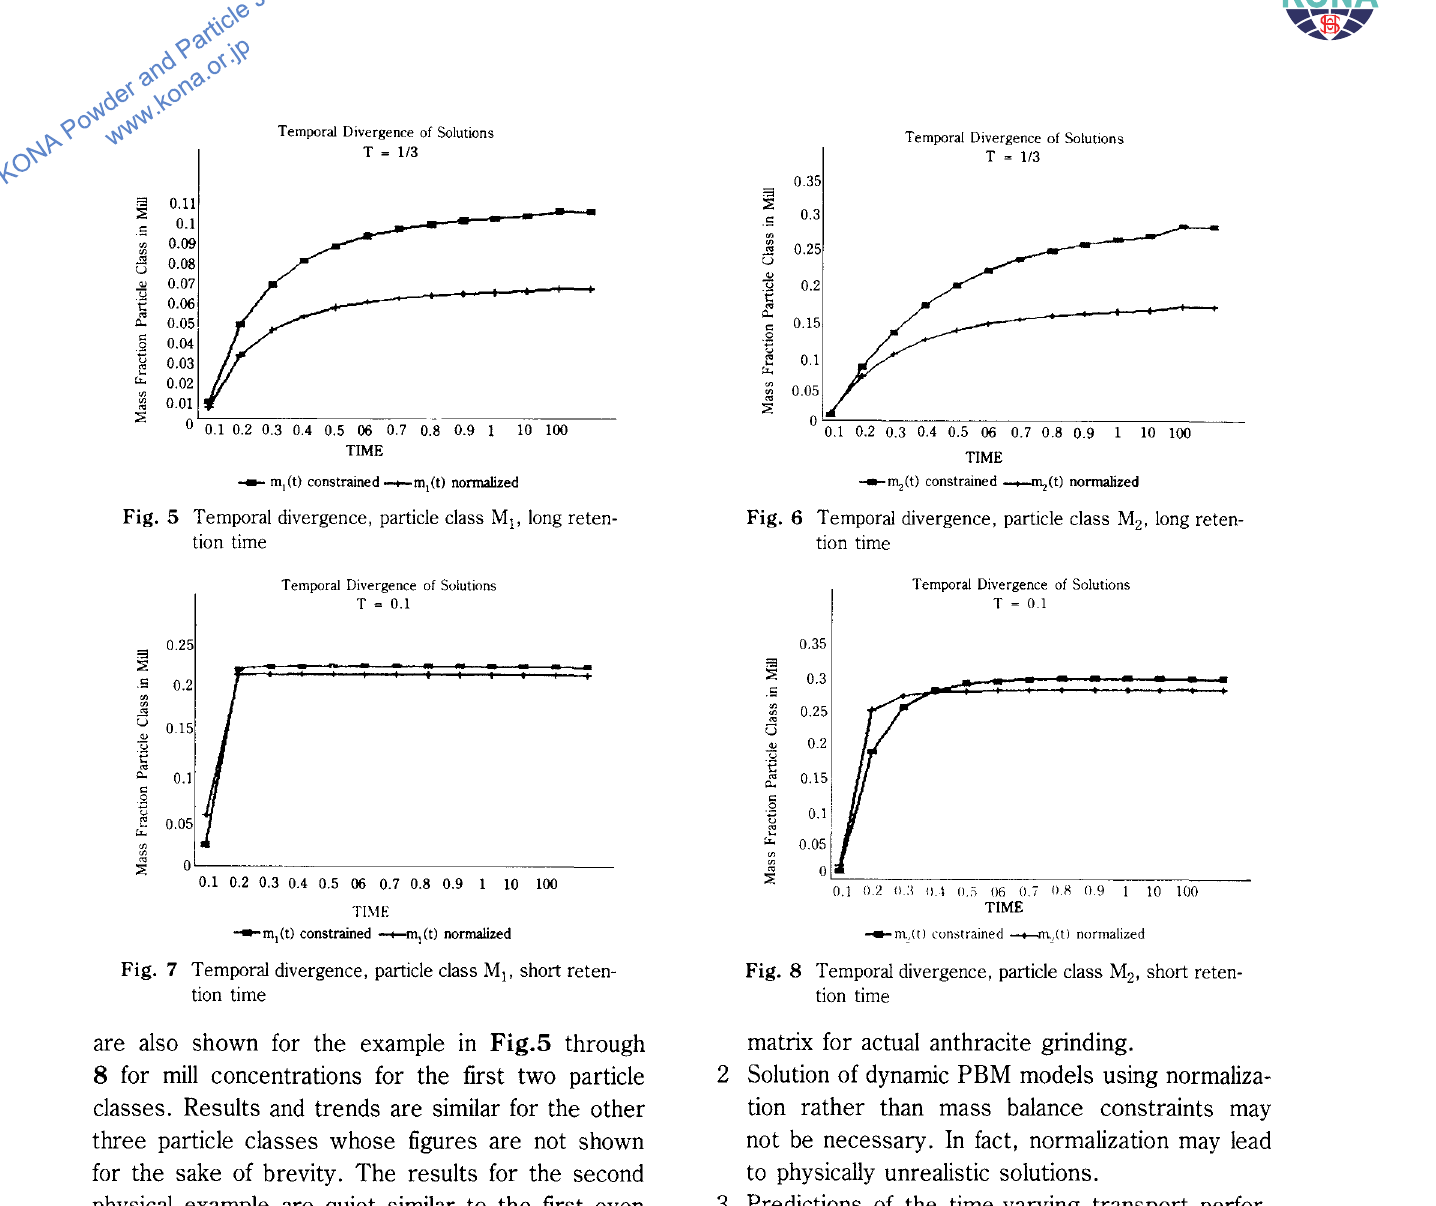
Fig. 8 Temporal divergence, particle class M 2, short reten tion time matrix for actual anthracite